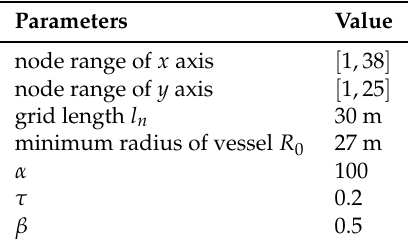
Table 1. Parameter initialization.